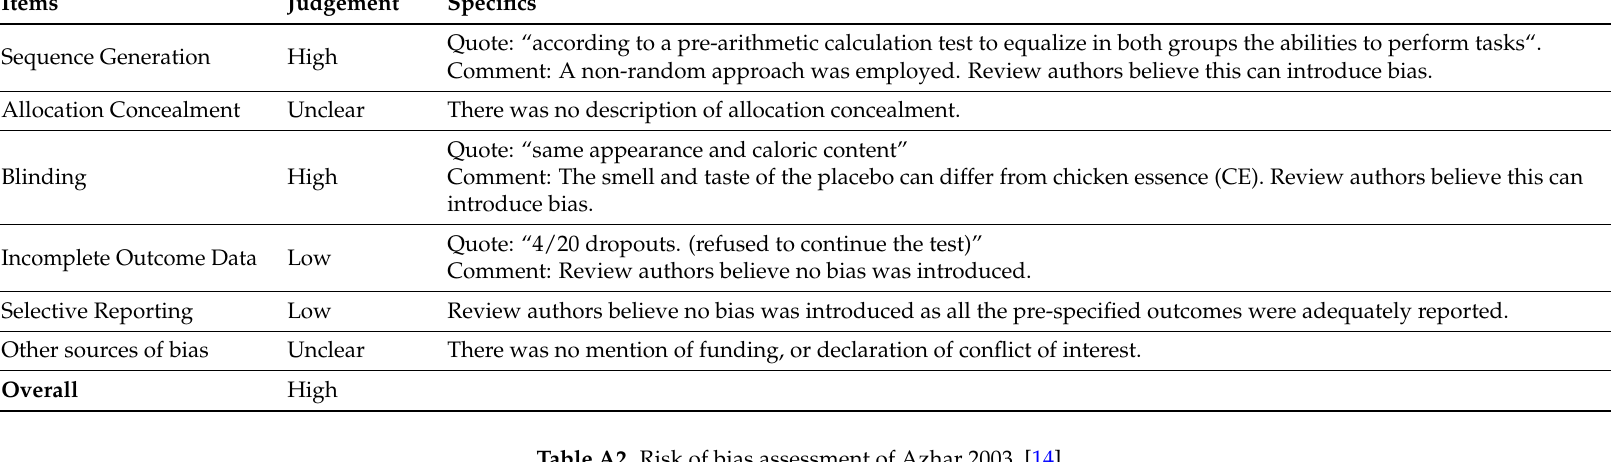
Table A1. Risk of bias assessment of Nagai 1996 [4].